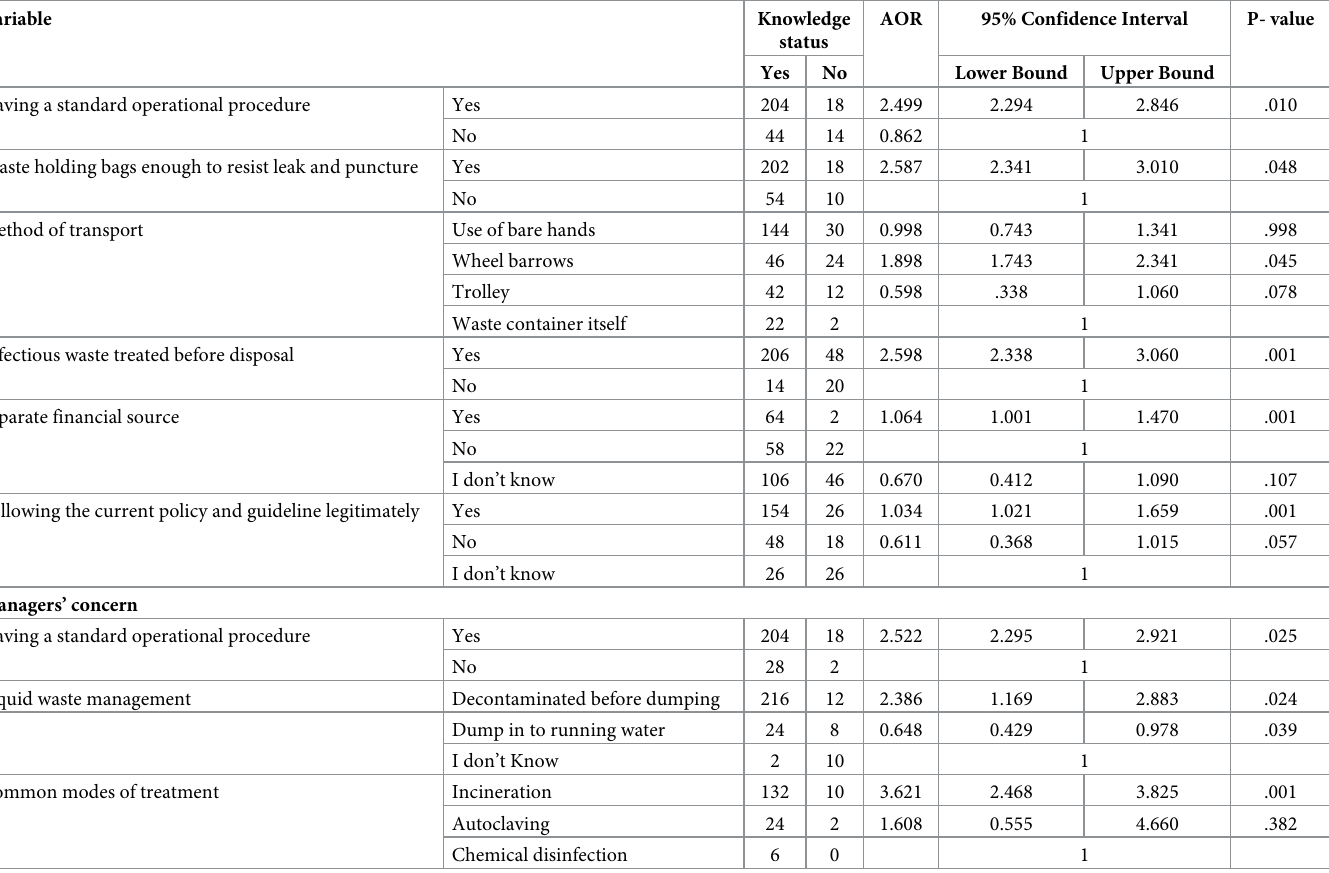
Table 6. Multivariate logistic regression analysis which shows the association of knowledge with the practice of biomedical waste management, Addis Ababa, Ethio- pia,